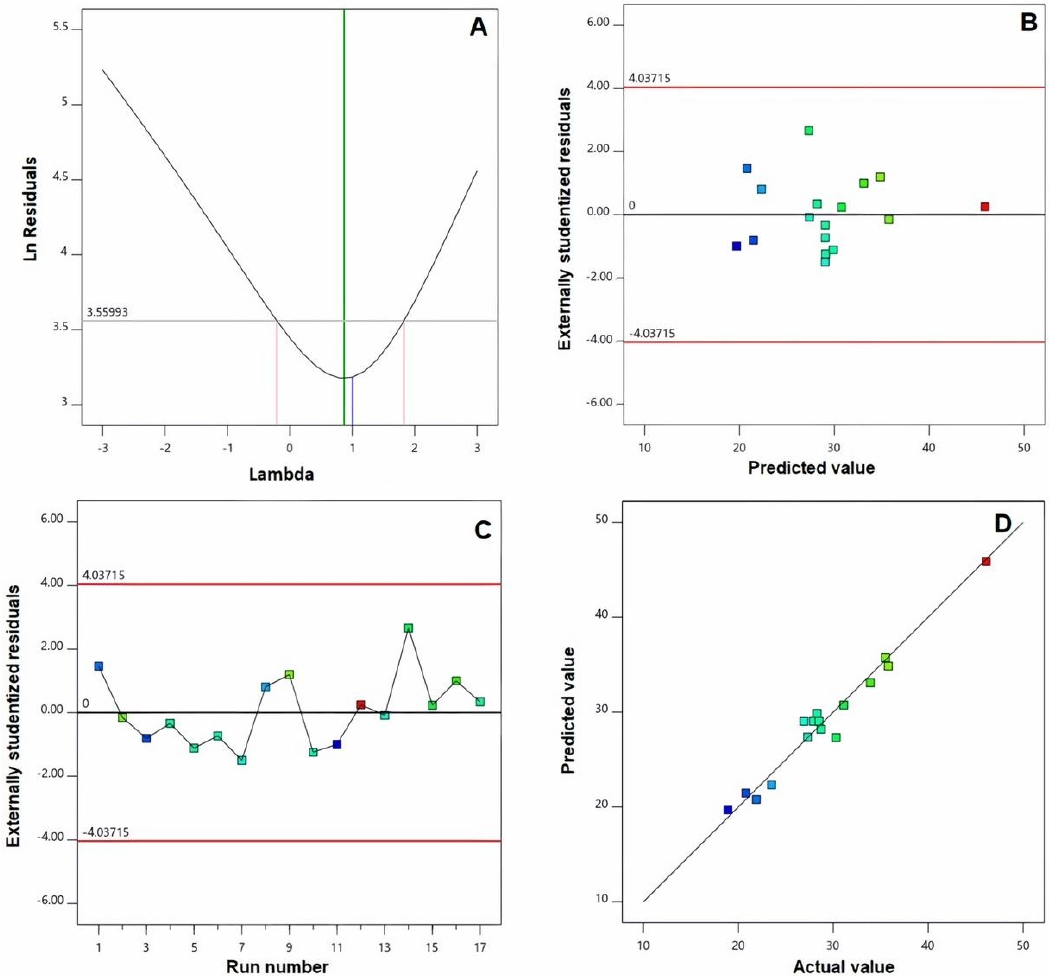
Figure 2. Diagnostic plots for zeta potential of EGA-EML-APA. ( A ) Box–Cox plot for power trans- forms ( B ) externally studentized residuals vs. predicted values plot ( C ) externally studentized residuals vs. run number plot and ( D ) predicted vs. actual values plot. Abbreviations: EGA, ellagic acid; EML, emulsomes; APA, apamin.